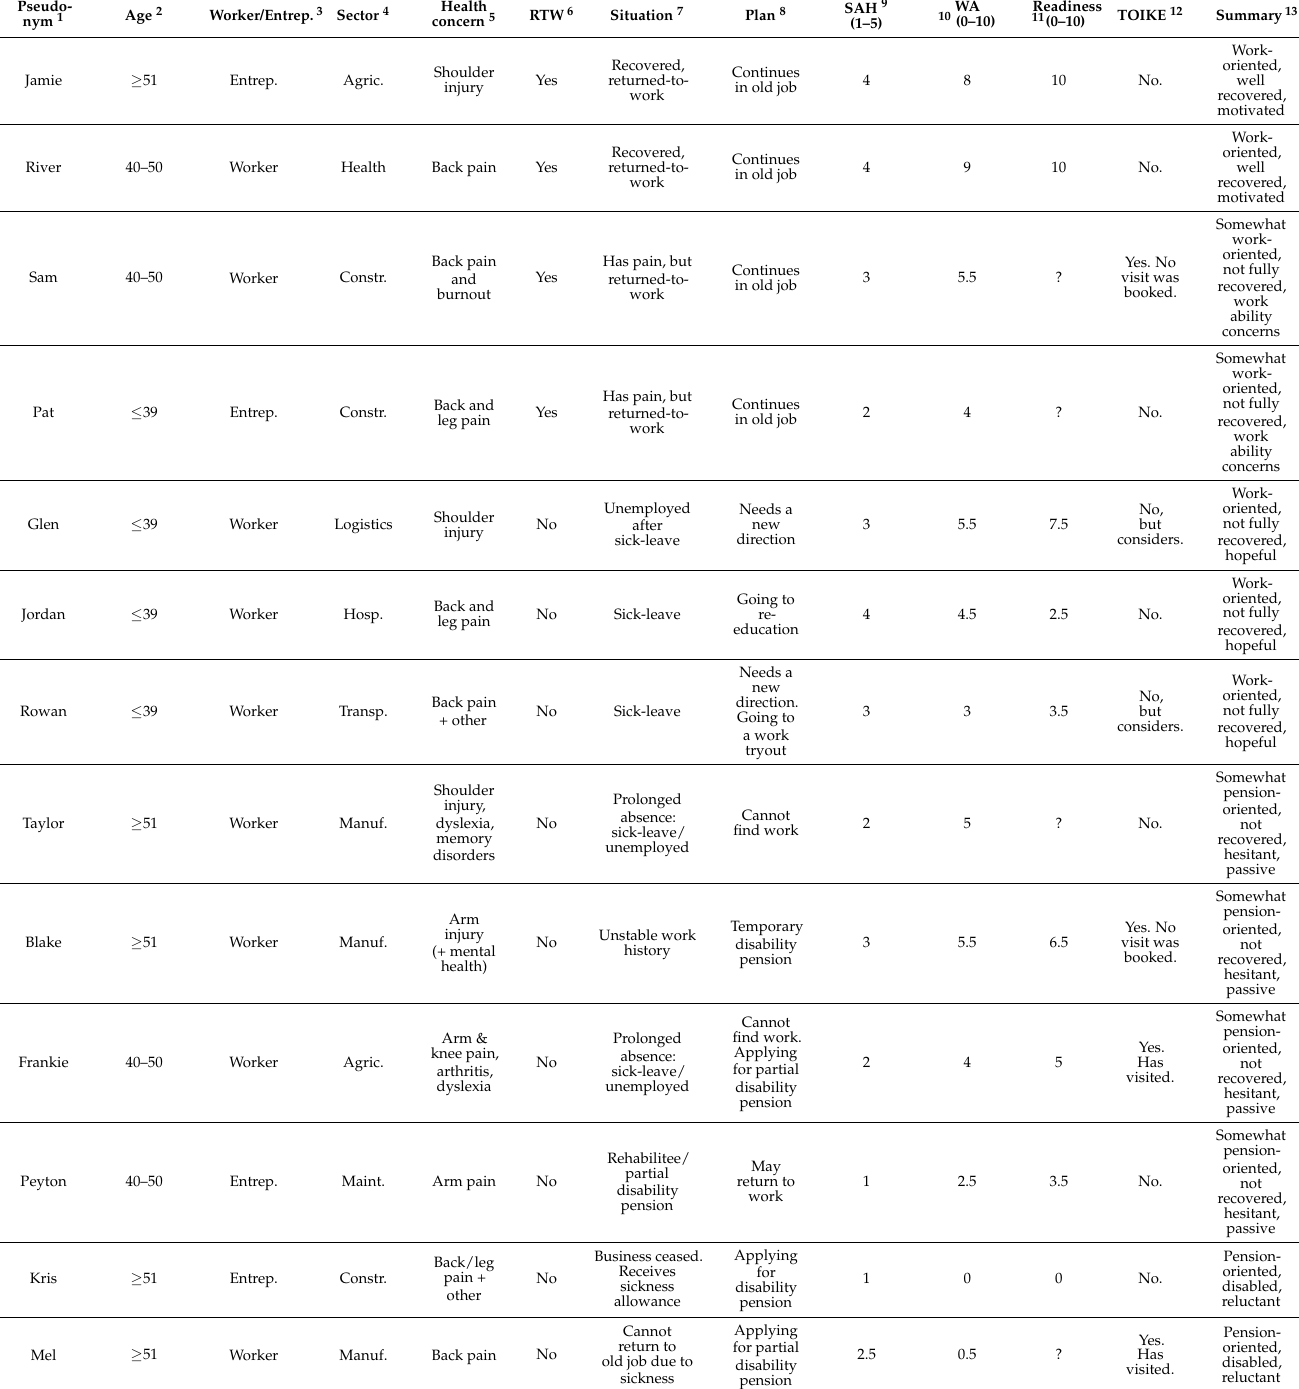
Mel ≥ 51 Worker Manuf. Backpain No